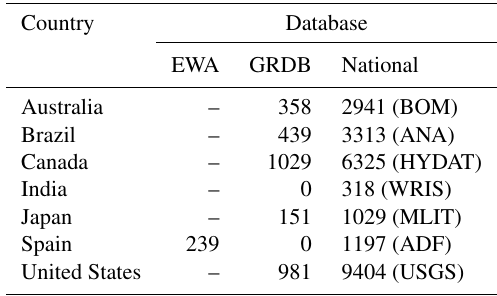
Table 2. Number of stations in countries where national databases are